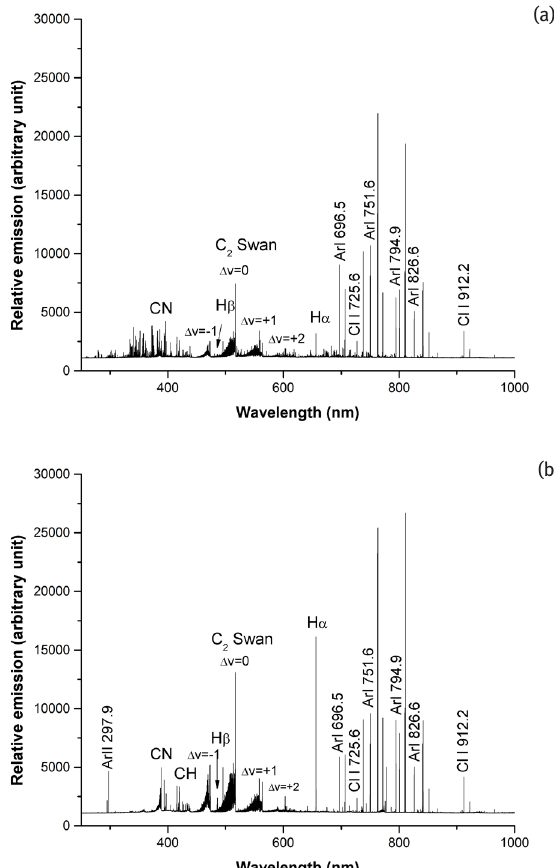
Figure 2 : Optical emission spectra of the plasma during PVC decomposition in neutral (Run-1) (a) and reductive (Run-8) (b) environment recorded 70 mm beneath the